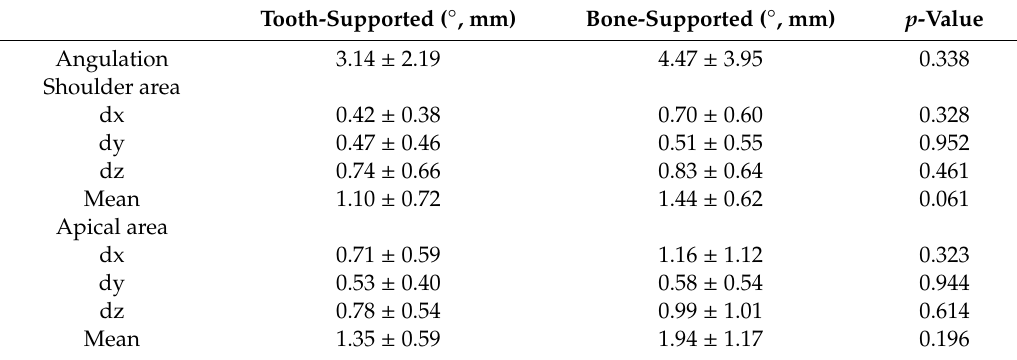
Table 6. Tooth-supported vs. bone-supported (mean ±